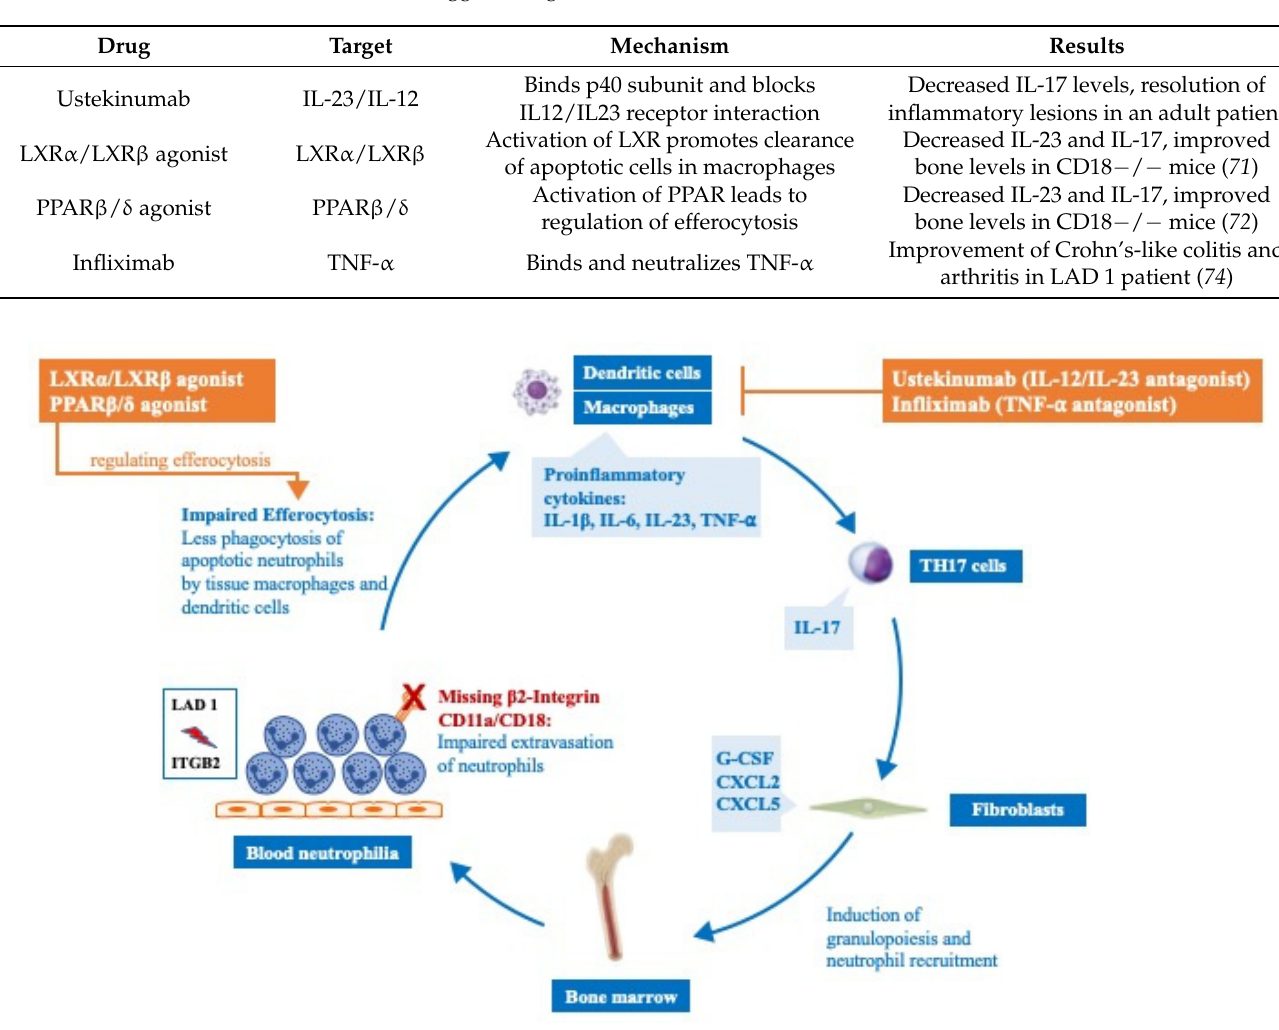
Table 1. Druggable targets in LAD-1.